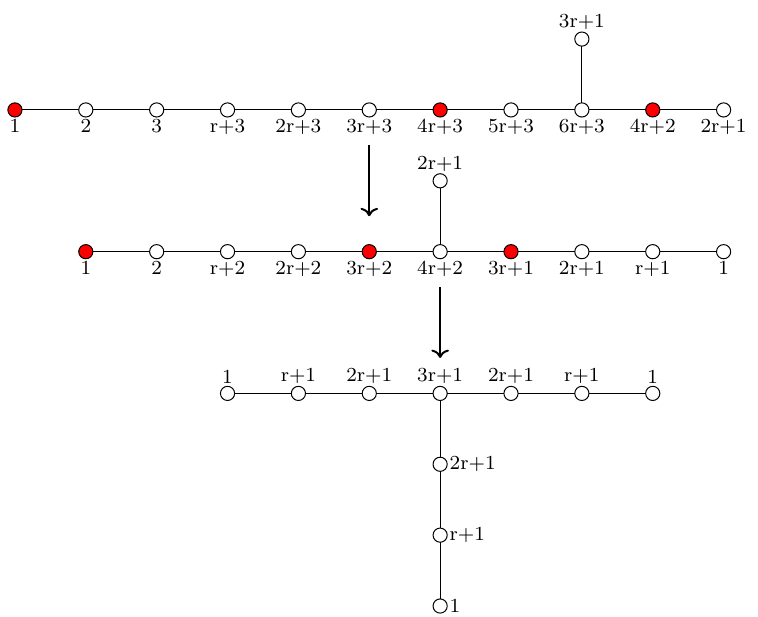
Figure 6. The FI deformations leading to the magnetic quiver of the 5d SCFT which gives the quiver of S ( r ) theories upon Z 3 D 4 , 3